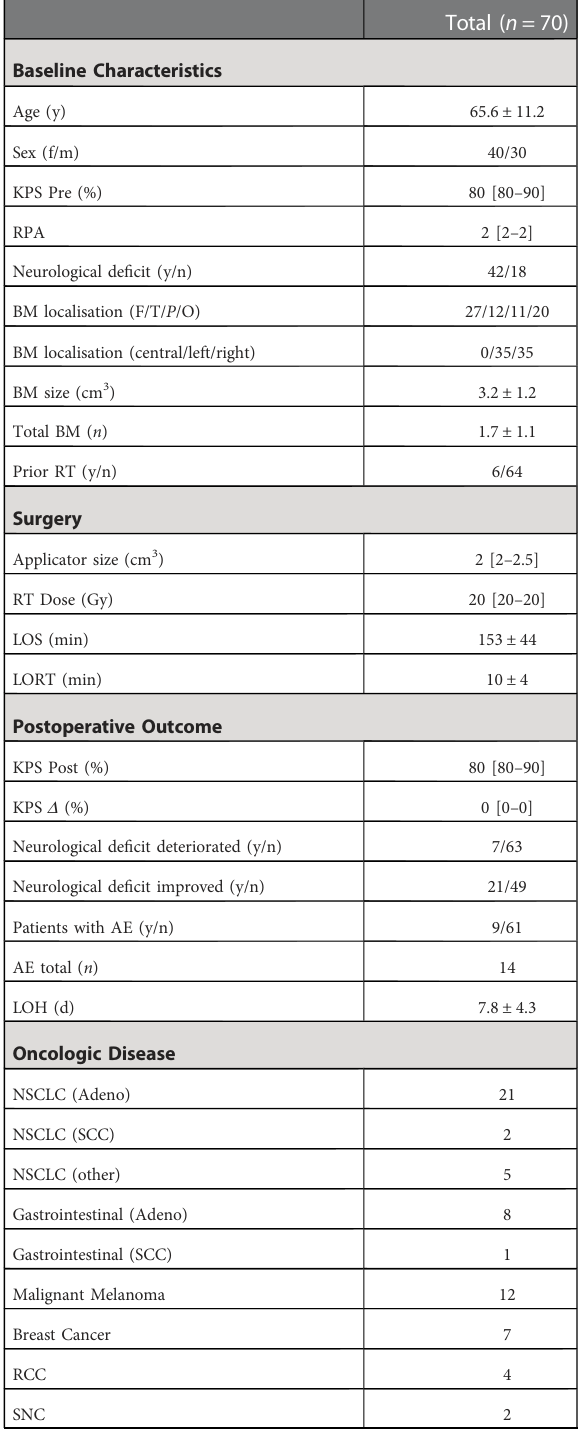
TABLE 1 Baseline characteristics: y, years; f/m, female/Male; KPS, Karnofsky performance score; Pre, preoperative; RPA, recursive partitioning analysis; y/n, yes/no; BM, brain metastasis; F, frontal; T, temporal; P , parietal; O, occipital; n , number; RT, radiotherapy; Gy, gray; LOS, length of surgery; LORT, length of radiotherapy; post, postoperative; AE, adverse event; LOH, length of hospitalization; d, days; NSCLC, non-small cell lung cancer; SCC, squamous cell cancer; RCC, renal cell cancer; SNC, sinunasal cancer; data is shown as [mean±SD/median (interquartile